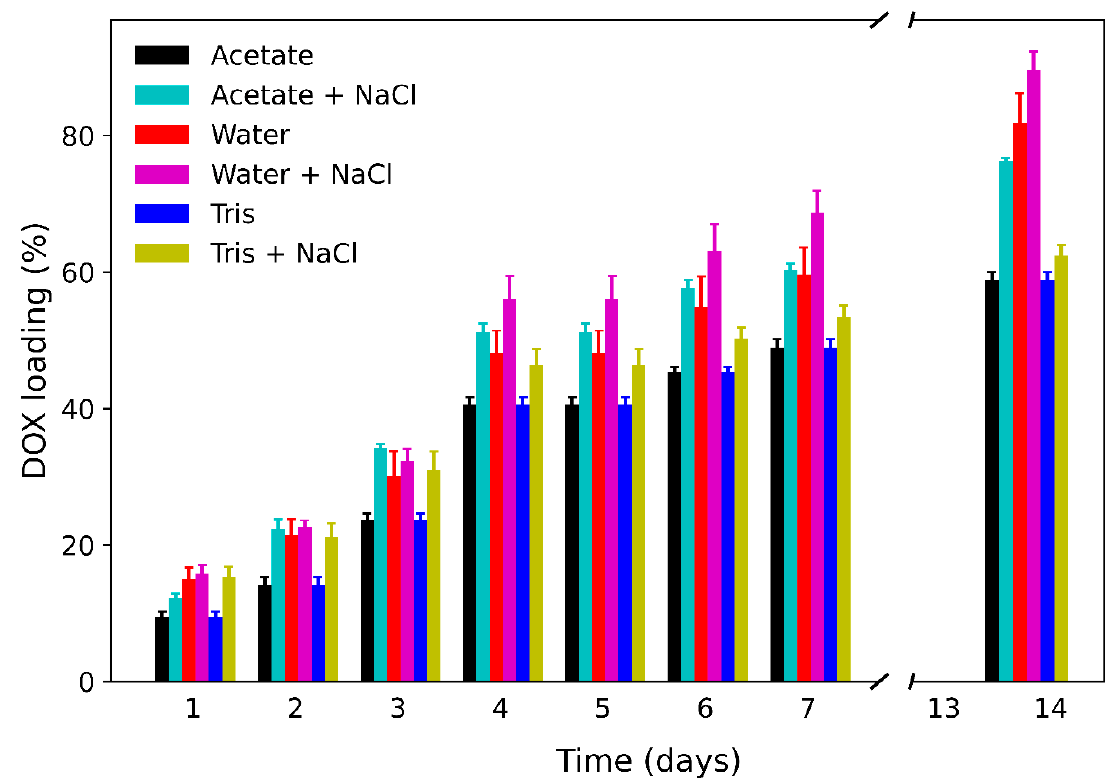
Figure 5. Loading of DOX inside np-Au from low concentration (25 µM) solution at a different pH environment with or without 0.14 M NaCl.